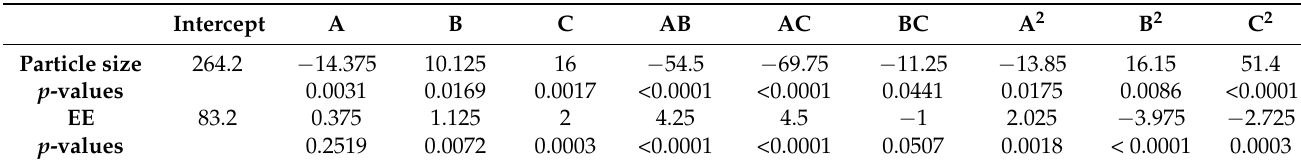
Table 4. ANOVA coefficients for both